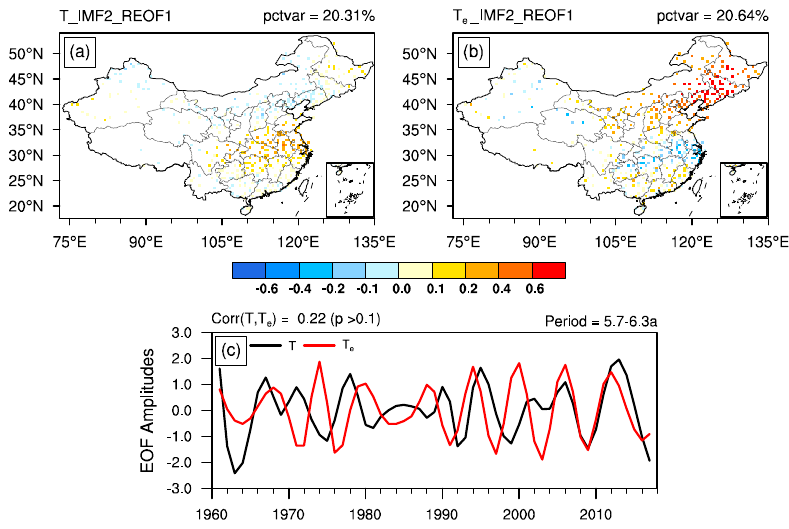
Figure 3. The first REOF modes of the IMF 2 of summertime T ( a ) and T e ( b ) in China, and the corresponding principal component ( c ). Note that the “pctvar” in the figure means percent variance; “Corr” means correlation coefficient between T and T e ; Black (Red) line represents the principal component of T ( T e ).